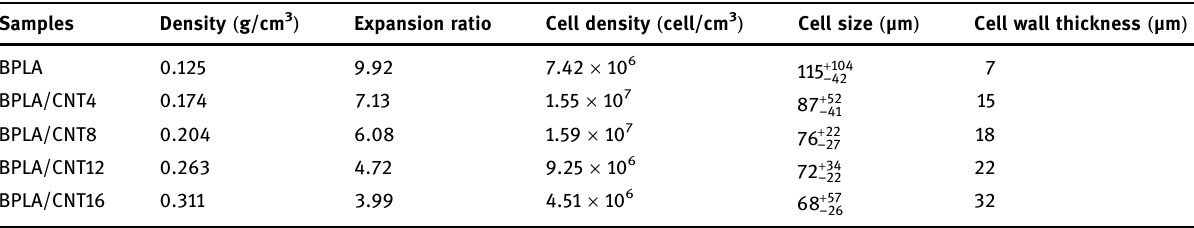
Table 2: Cellular morphology parameters of BPLA/CNT foams